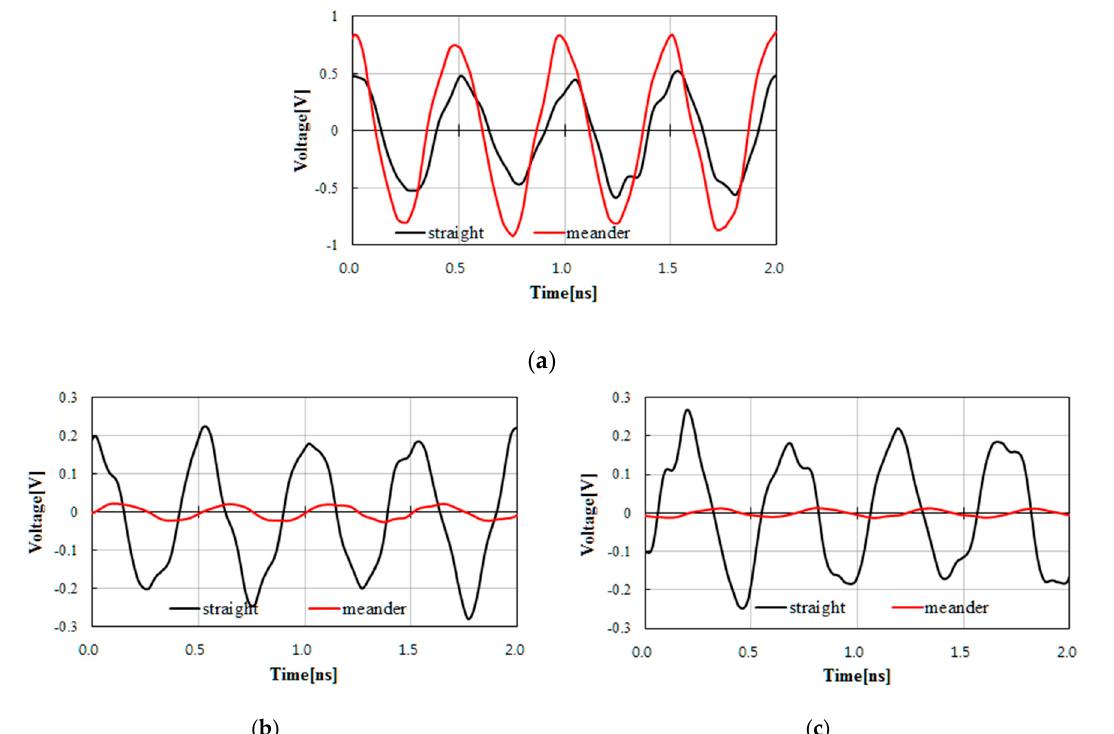
Figure 12. Comparison of the transmission and crosstalk signal with the straight and meander split power or ground plane. ( a ) Transmission signal measured at port #2; ( b ) near-end crosstalk signal measured at port #3; ( c ) far-end crosstalk signal measured at port #4.